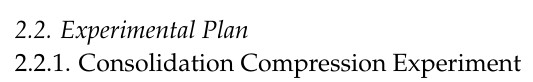
Figure 2. The QUANTA FEG 650 field emission scanning electron microscope. Table 1. Physical and mechanical parameters of the soil sample.